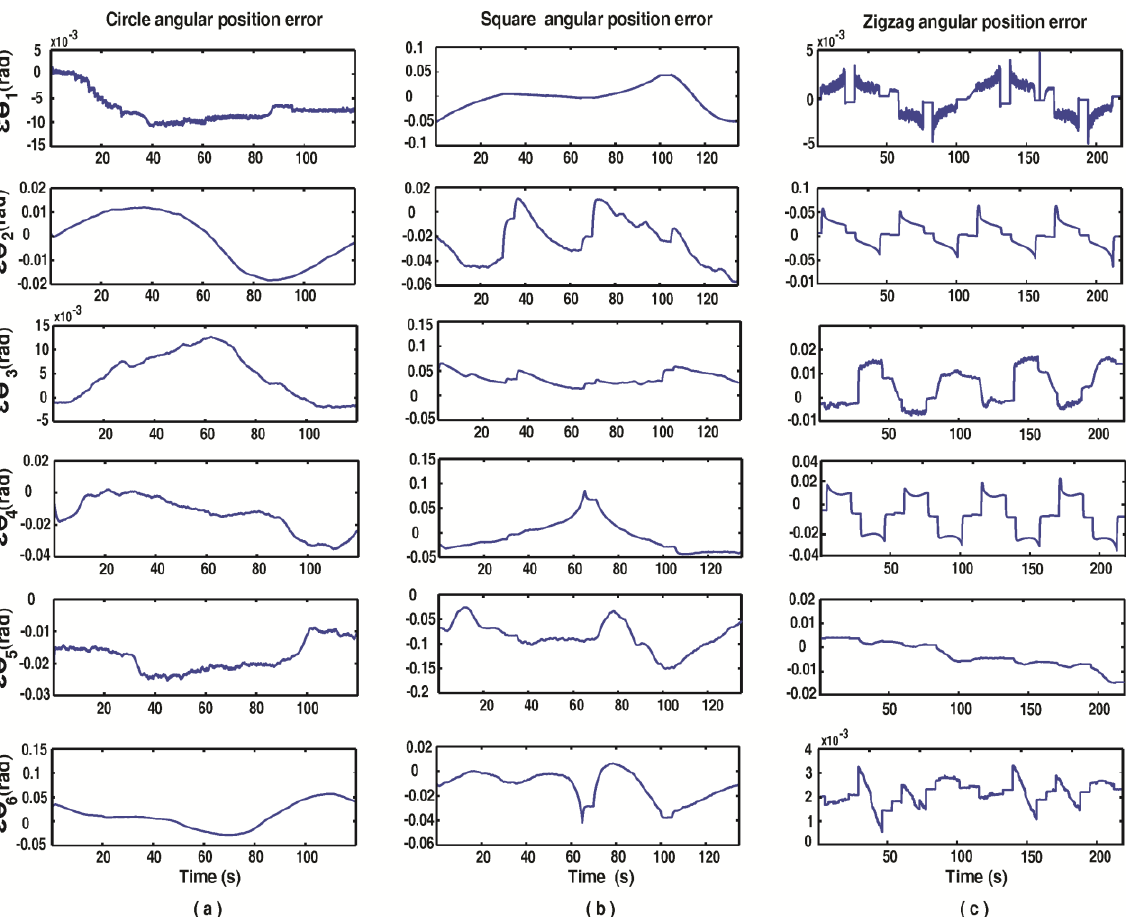
Figure 11. Monitored controller errors for each joint in the case of (a) circle path, (b) square path and (c) zigzag path.